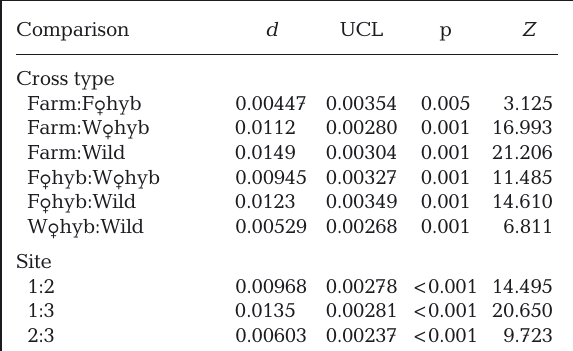
Table 1. Distances (d) between least-squares means for pair- wise cross type and site comparisons of fish shape in Atlantic salmon, as well as the upper 95% confidence limit (UCL) of the distribution generated through the resampling process, and the number of standard deviations the distance is away from the mean distance generated through the